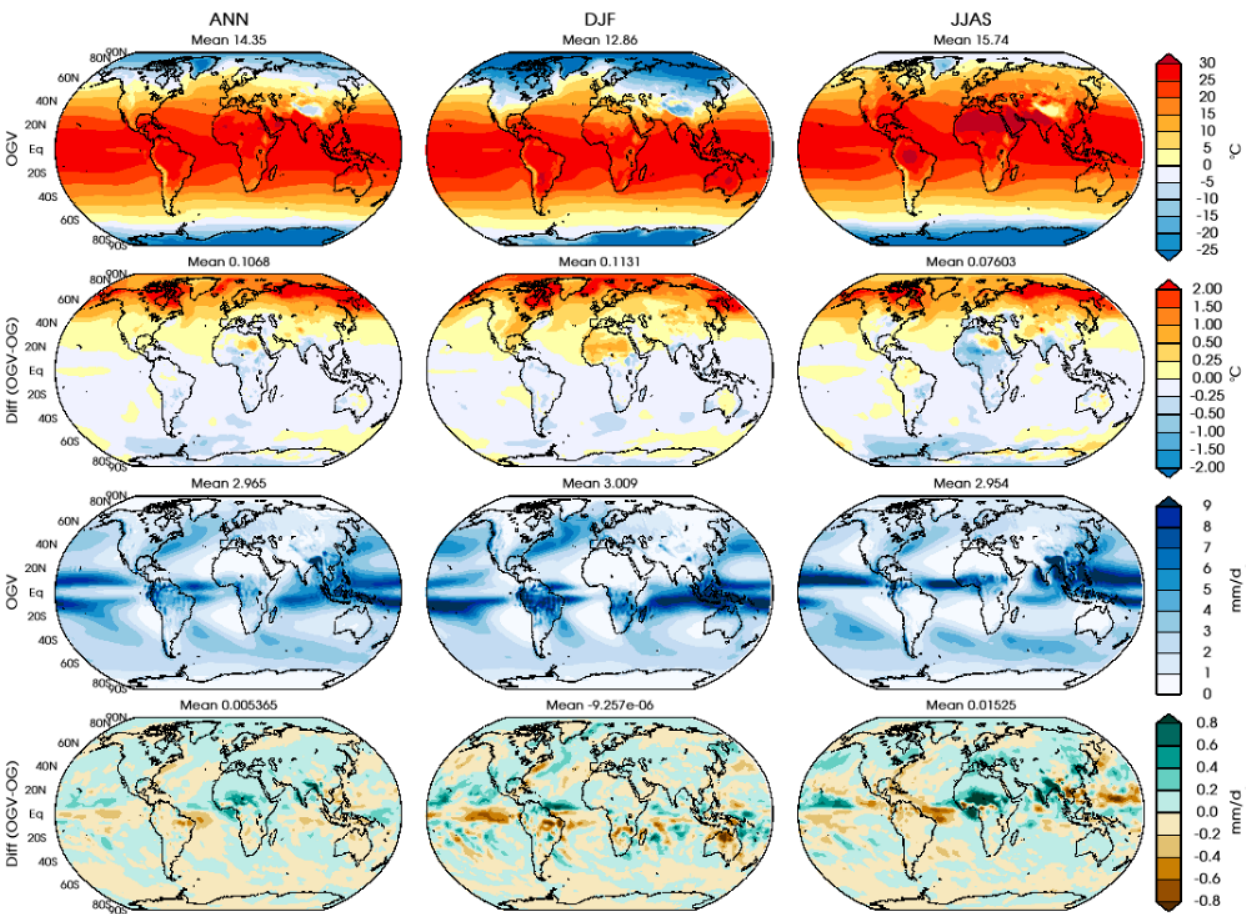
Figure 2. Mean surface air temperature for annual, DJF, and JJAS seasons (top row) and seasonal mean precipitation (third row from top) for the equilibrium runs with the PMIP4 vegetation for the 2.5ka period, and surface temperature difference (second row from top) plus the seasonal precipitation differences (bottom row) for the 2.5ka period, as simulated by GISS ModelE2.1. We have used a short initial notation for our forcings to denote the difference (ORB + GHG + VEG = OGV and ORB + GHG =